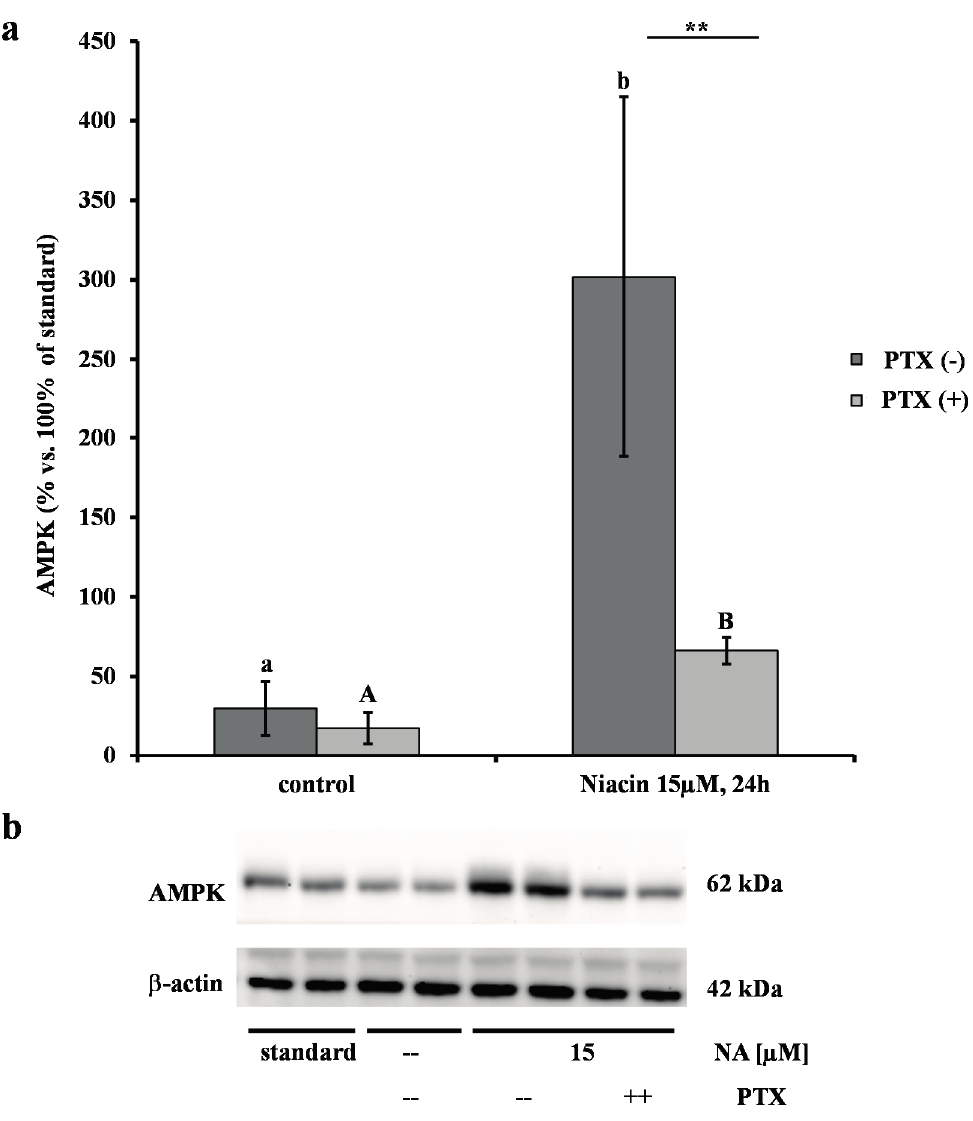
Figure 2. Effects of nicotinic acid (NA) on 5' AMP-activated protein kinase (AMPK) protein abundance (means ± SEM) in differentiated bovine adipocytes ( n = 5). After 4 h of starvation, the adipocytes were pre-incubated with (PTX (+)) or without pertussis toxin (PTX ( − )) (100 ng/mL) for 16 h and then treated for 24 h with 15 µM NA or PBS (control). ( a ) The different lower case letters designate significant differences ( p ≤ 0.001) between the NA treatments and the controls for the PTX ( − ) cells. The different upper case letters designate significant differences ( p ≤ 0.001) between the NA treatments and the controls for the PTX (+) cells. Significant differences ( ** p ≤ 0.01) due to (+) or ( − ) PTX pre-incubation are designated with asterisks; ( b ) Representative Western blot results. After gel electrophoreses, the membranes were incubated with specific antibodies against AMPK or β -actin as a loading control. The obtained optical densities for AMPK were matched against a standard pool sample and are expressed as % relative to the